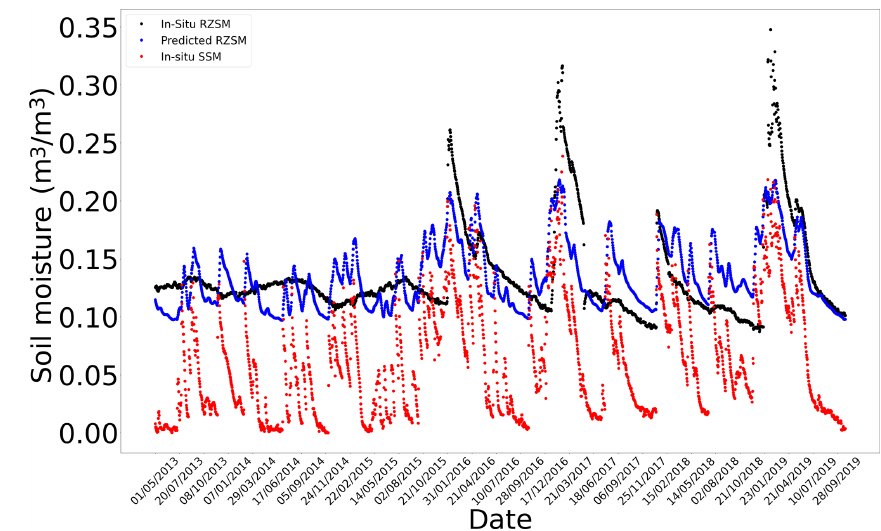
Figure F3. In situ SSM, in situ RZSM, and predicted RZSM series at station PineNut with model ANN_SSM.